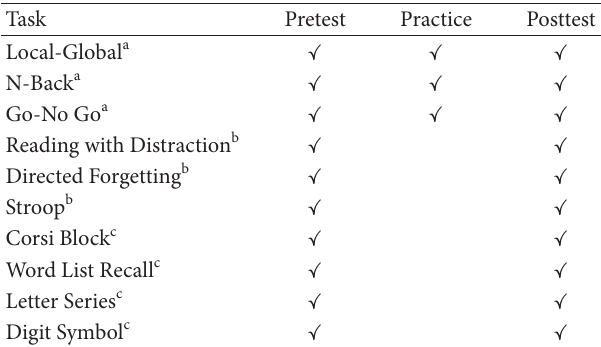
Table 2: List of tasks administered at pretest, practice, and posttest